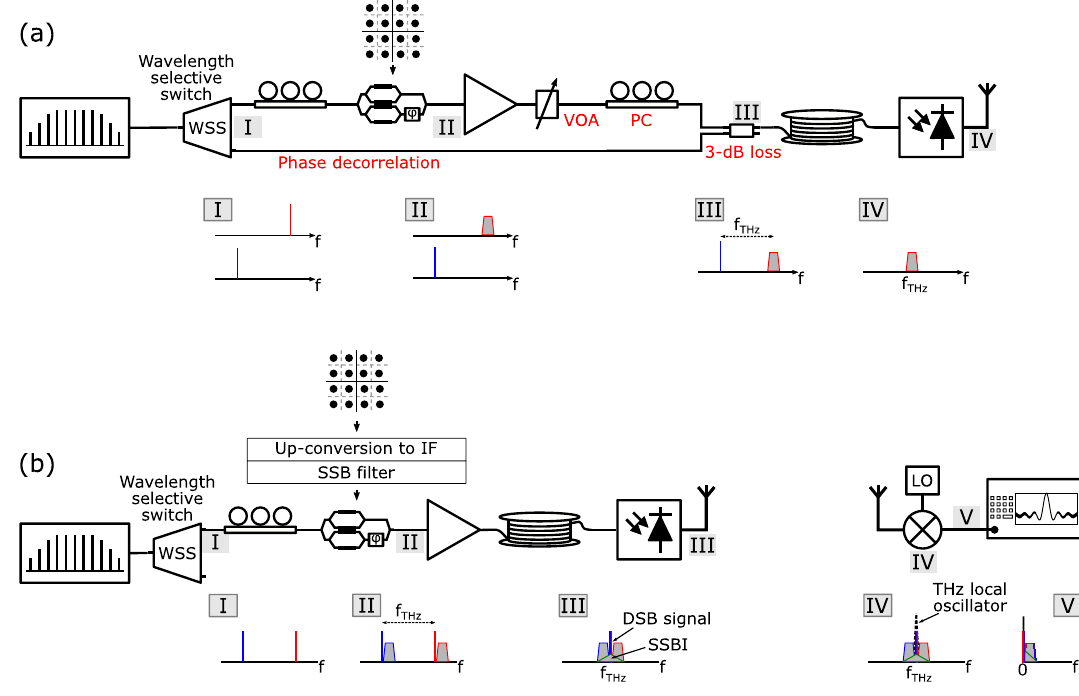
Figure 1. THz transmitters: ( a ) heterodyne transmitter, ( b ) proposed single-path THz transmitter with SSB-C optical modulation and DSB receiver. SSB-C: single sideband with carrier, DSB: double sideband, IF: intermediate frequency, SSBI: signal-signal beat